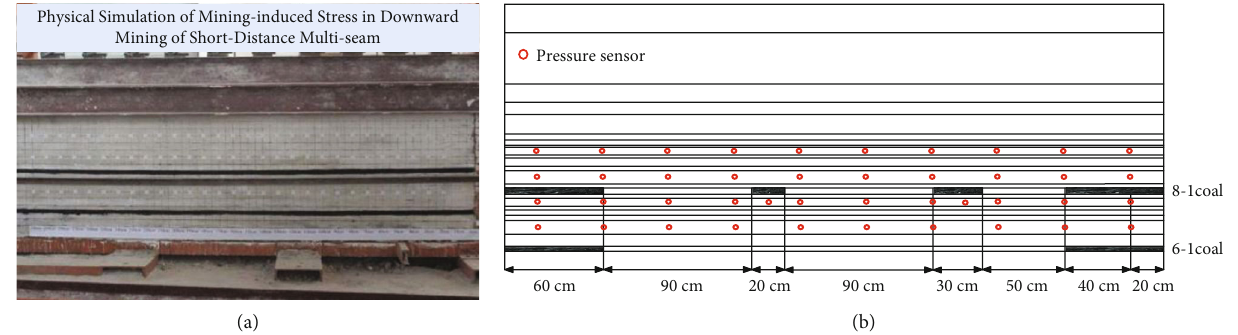
Figure 4: Physical simulation: (a) model and (b) schematic diagram of pressure sensor layout and mining.